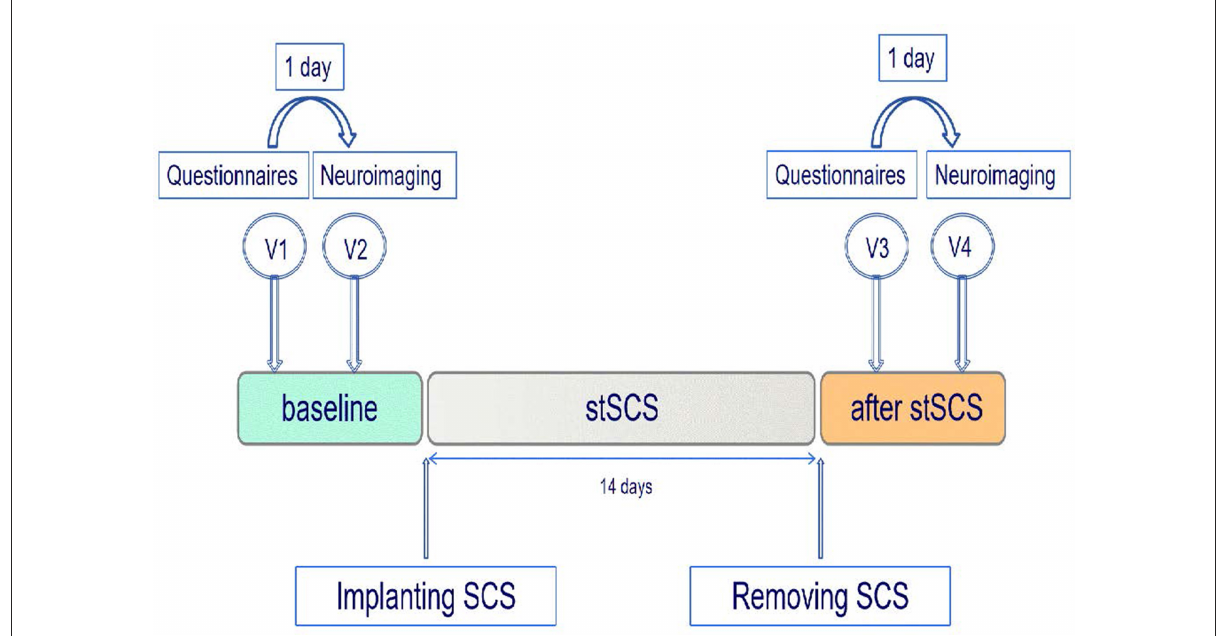
FIGURE1 Study protocol. Patients with PHN were enrolled prior to the implantation of the SCS and were followed up after the removal of the stSCS. Each patient underwent a neuroimaging protocol prior to SCS and 14 days after SCS. SCS, spinal cord stimulation; stSCS, short-time spinal cord stimulation; V,